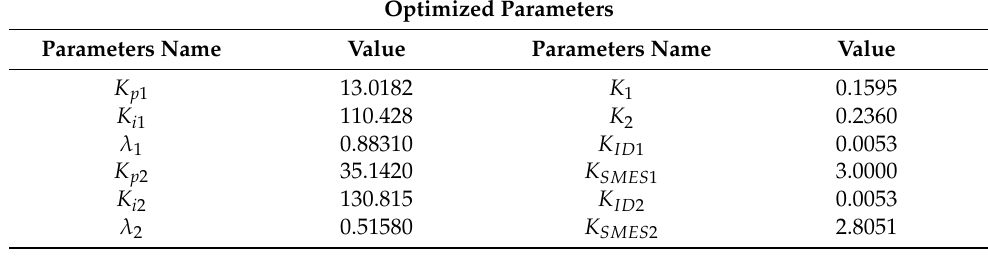
Table 2. Optimized Controller Parameters.